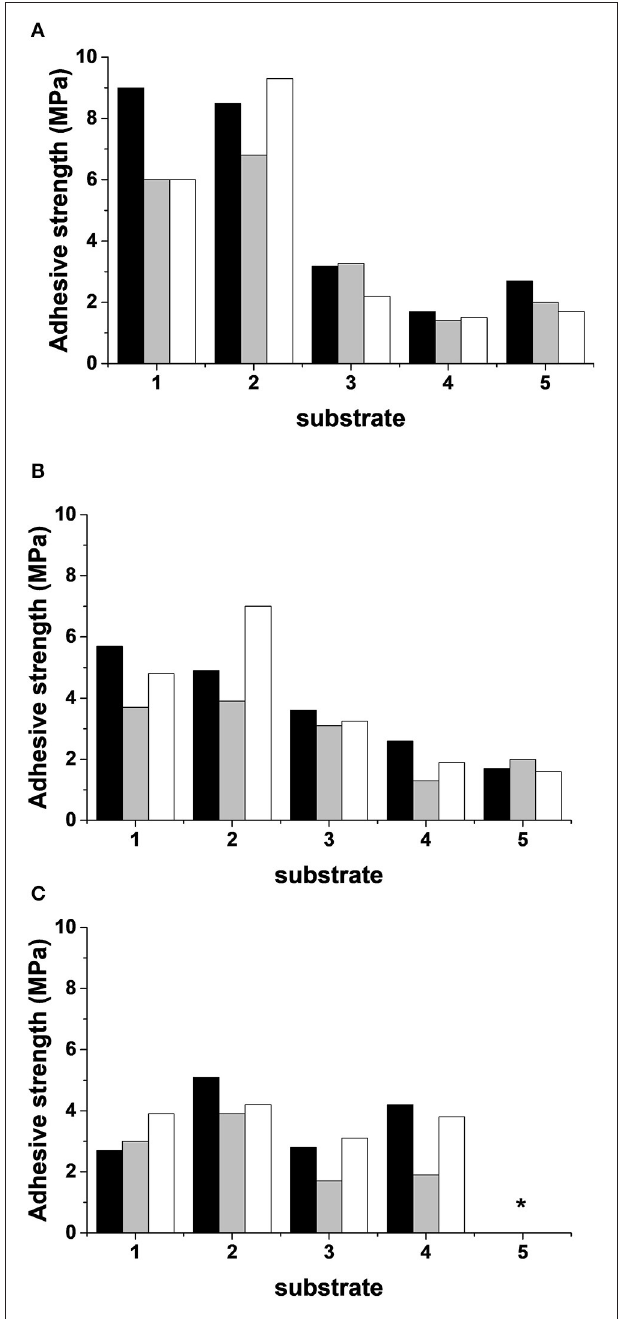
FIGURE 5 | Adhesive strength ( ± 0.5 MPa) of the coatings S1M1 (Black), S1A3M1Sbl (Gray) and S1A5M1Sb2 (White), applied on the five substrates. With (A) stored at (T = 20 ◦ C, RH = 50%), (B) at (T = 20 ◦ C, RH = 85%), (C) at (natural conditions, T = − 2.3–7.3 ◦ C; and RH = 40–99%), and (1 = white limestone; 2 = blue limestone; 3 = Fez stone; 4 = concrete, and 5 = plaster), *the coating delaminated from plaster substrate in external conditions.